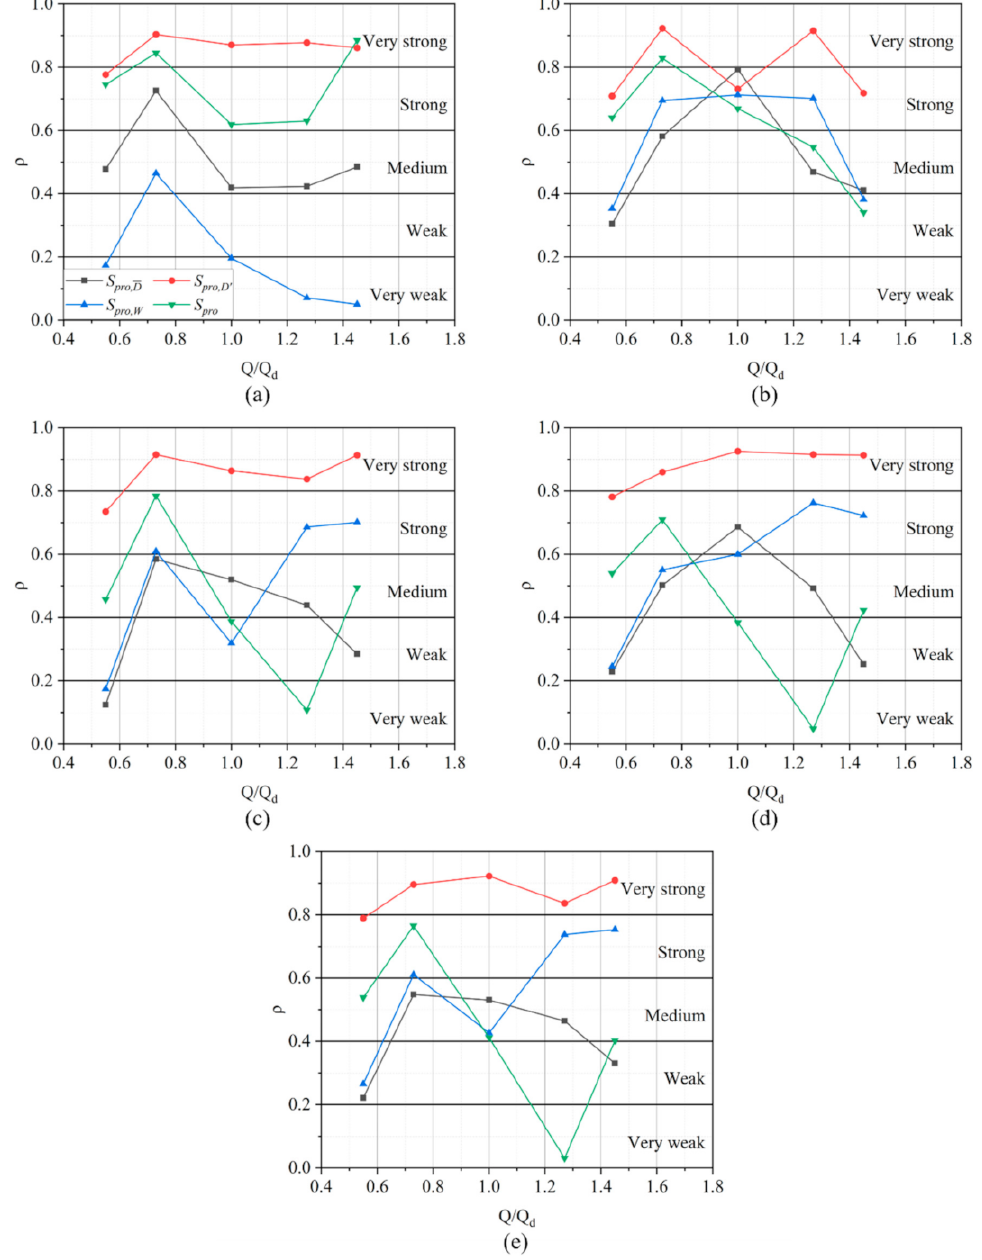
Figure 21. Correlation between dissipation effect and entropy production. ( a ) guide vane1, ( b ) guide vane2, ( c ) guide vane3, ( d ) guide vane 4, ( e ) guide vane